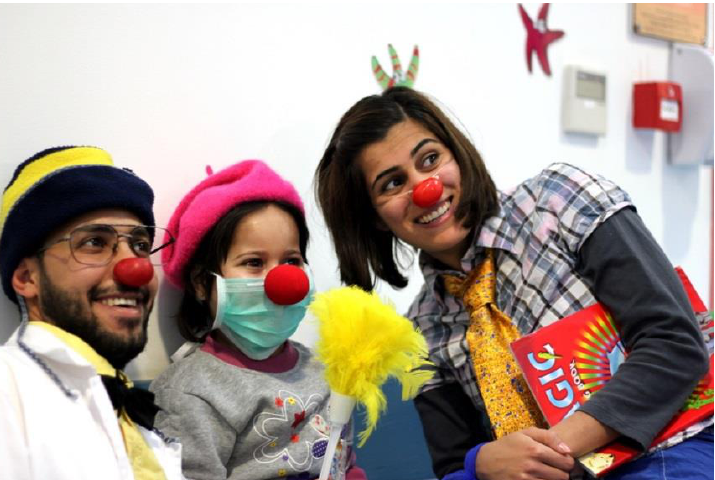
Figure 1. Regular children’s program in Beit Jala Governmental